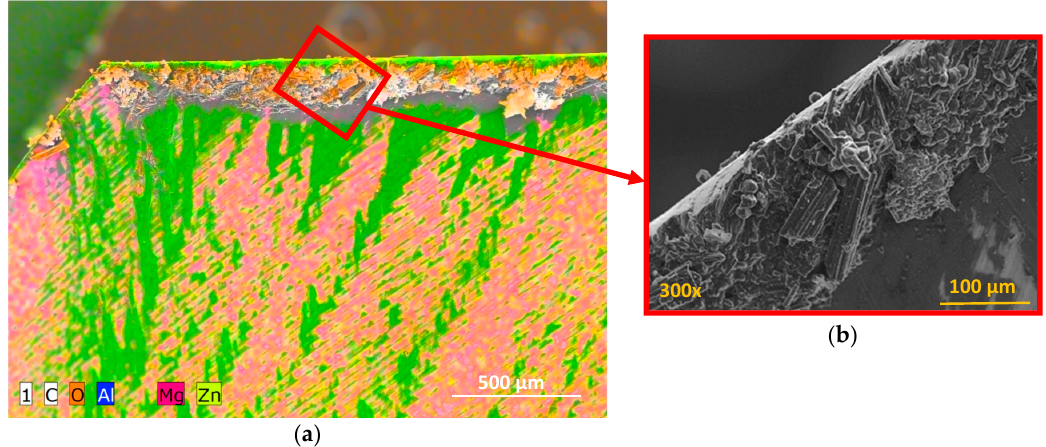
Figure 13. ( a ) Composition analysis of the BUE and release side after dry drilling of the stack CFRP/UNS A97075; ( b ) details of the BUE with carbon nanotube adhered to aluminium.